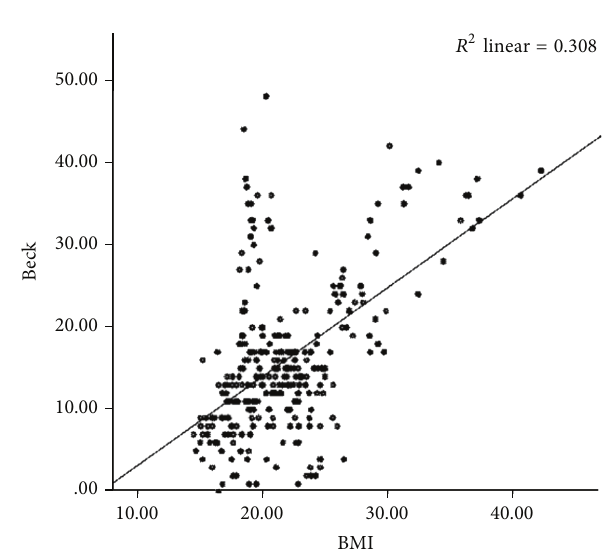
Figure 1: The relationship between BMI of high school female students and their degree of